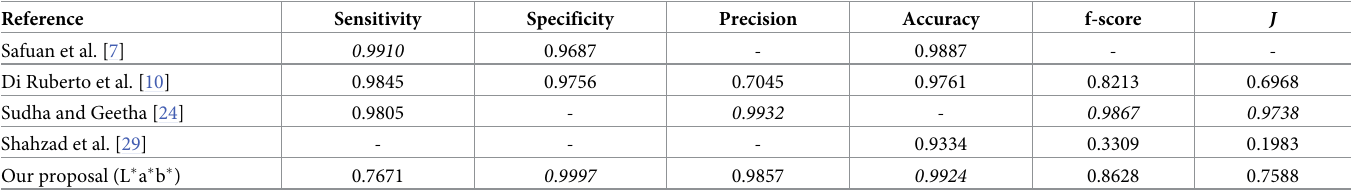
Table 4. Quantitative evaluation comparison of segmented images regarding the ALL-IDB ground truth, using different methods.